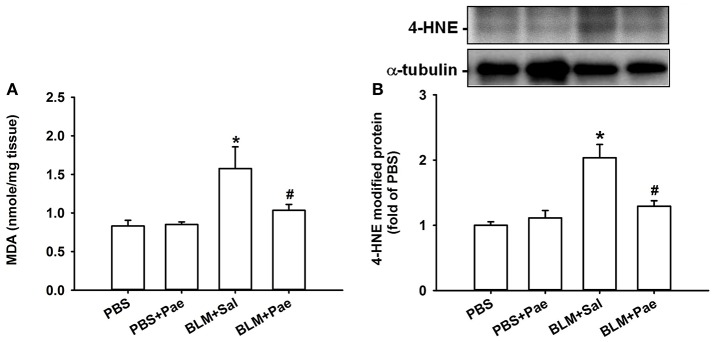
Treatment with paeonol (Pae) alleviates bleomycin (BLM)-induced increase in indices of pulmonary oxidative stress in mice. The indices measured were levels of malondialdehyde (MDA, A) and 4-hydroxynonenal modified proteins (4-HNE, B) in lung tissues sampled from mice belonging to four study groups. Data in (A) were measured by an assay kit, whereas data in (B) were measured by Western blot analysis. Data in each group are mean ± SEM from 6 mice. *p < 0.05 vs. the PBS group; #p < 0.05 vs. the BLM group.